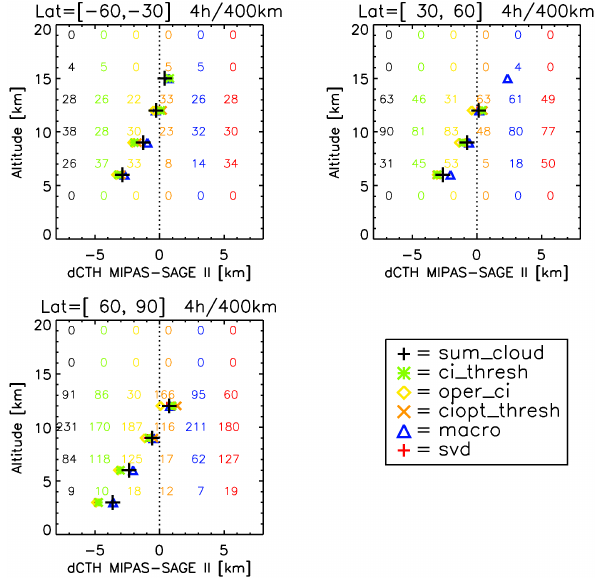
Fig. 17. Mean difference in CTH between MIPAS and SAGE II for coincident cloudy profile measurements between October 2002 and March 2004 on a 3km altitude grid and three latitude bins (60 ◦ S– 30 ◦ S, 30 ◦ N–60 ◦ N, and 60 ◦ N–90 ◦ N). Coloured symbols indicate the different MIPAS detection methods and the coloured numbers represent the counts of CTHs for MIPAS for the corresponding al- titude bin and detection